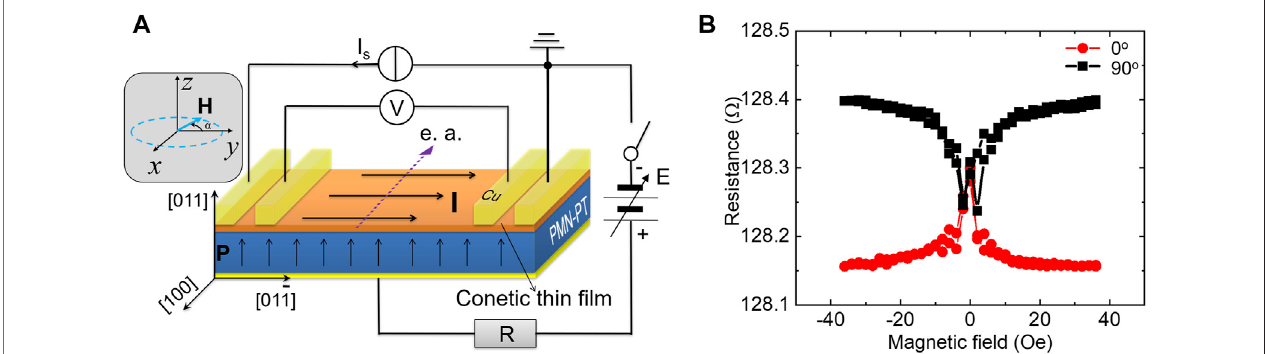
FIGURE1|(A) SchematicofaConeticalloythin fi lm/PMN – PTmultiferroicheterostructure.Thefour-probeMRmeasurementand insitu E- fi eldapplicationarealso shown here. (B) MR as a function of the applied in-plane magnetic fi eld Htoward α = 0 ° and 90 ° . Herein, α isthe angle between the in-plane magnetic fi eld and y-axis(or current I), as illustrated in the upper left corner of Figure 1. Magnetic fi eld H scans back and forth between − 36 and +36 Oe. Herein, the ferroelectric substrate PMN-PT was in a unpolarized